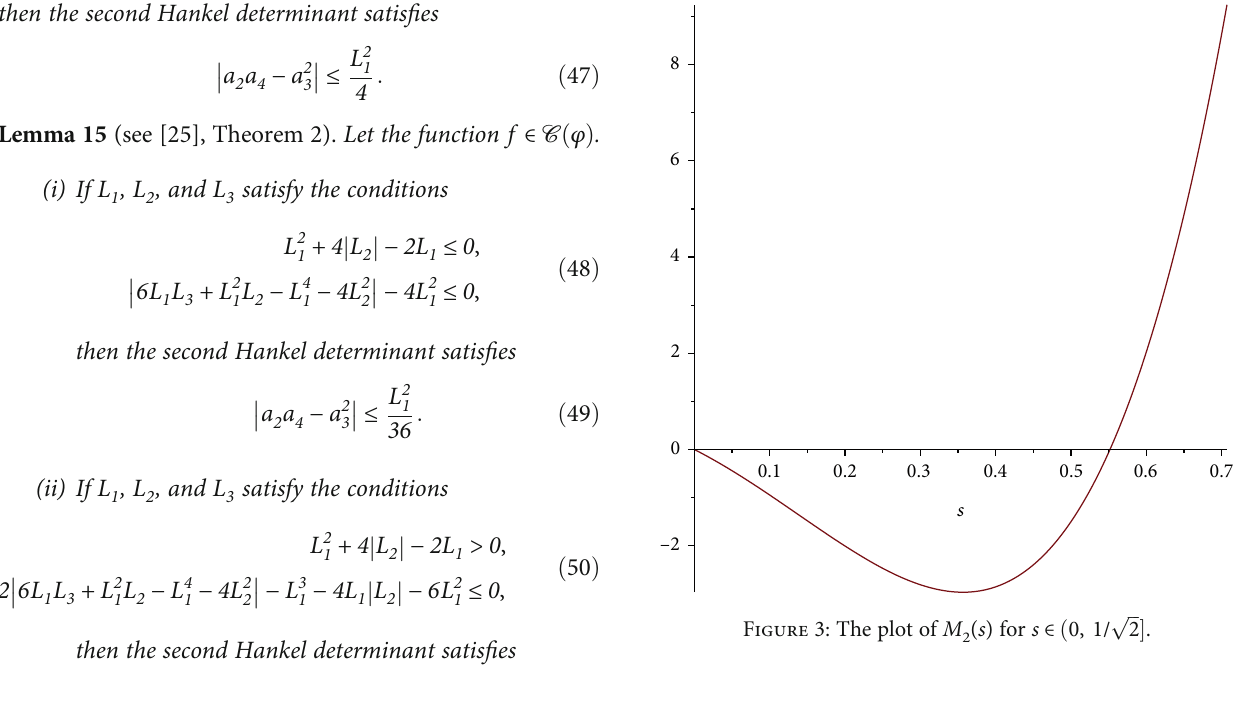
Figure 3: The plot of M